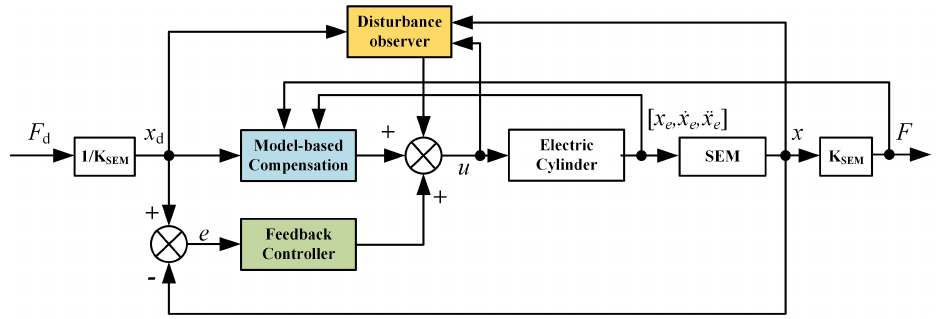
Figure 8. Block diagram of the SPEA control